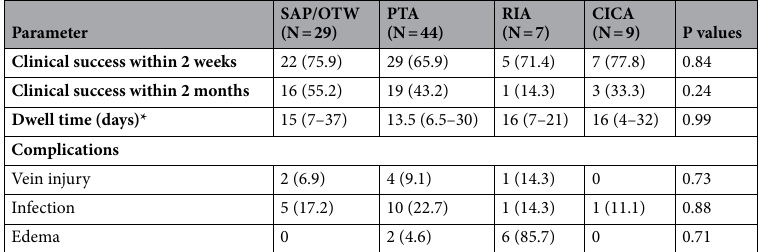
Table 4. Summary of the clinical outcomes according to the last technique (no. of procedures, n = 89). Data in parentheses are the percentages except for the dwell time. *Calculated using the Kaplan–Meier Methods. Data in parentheses are the